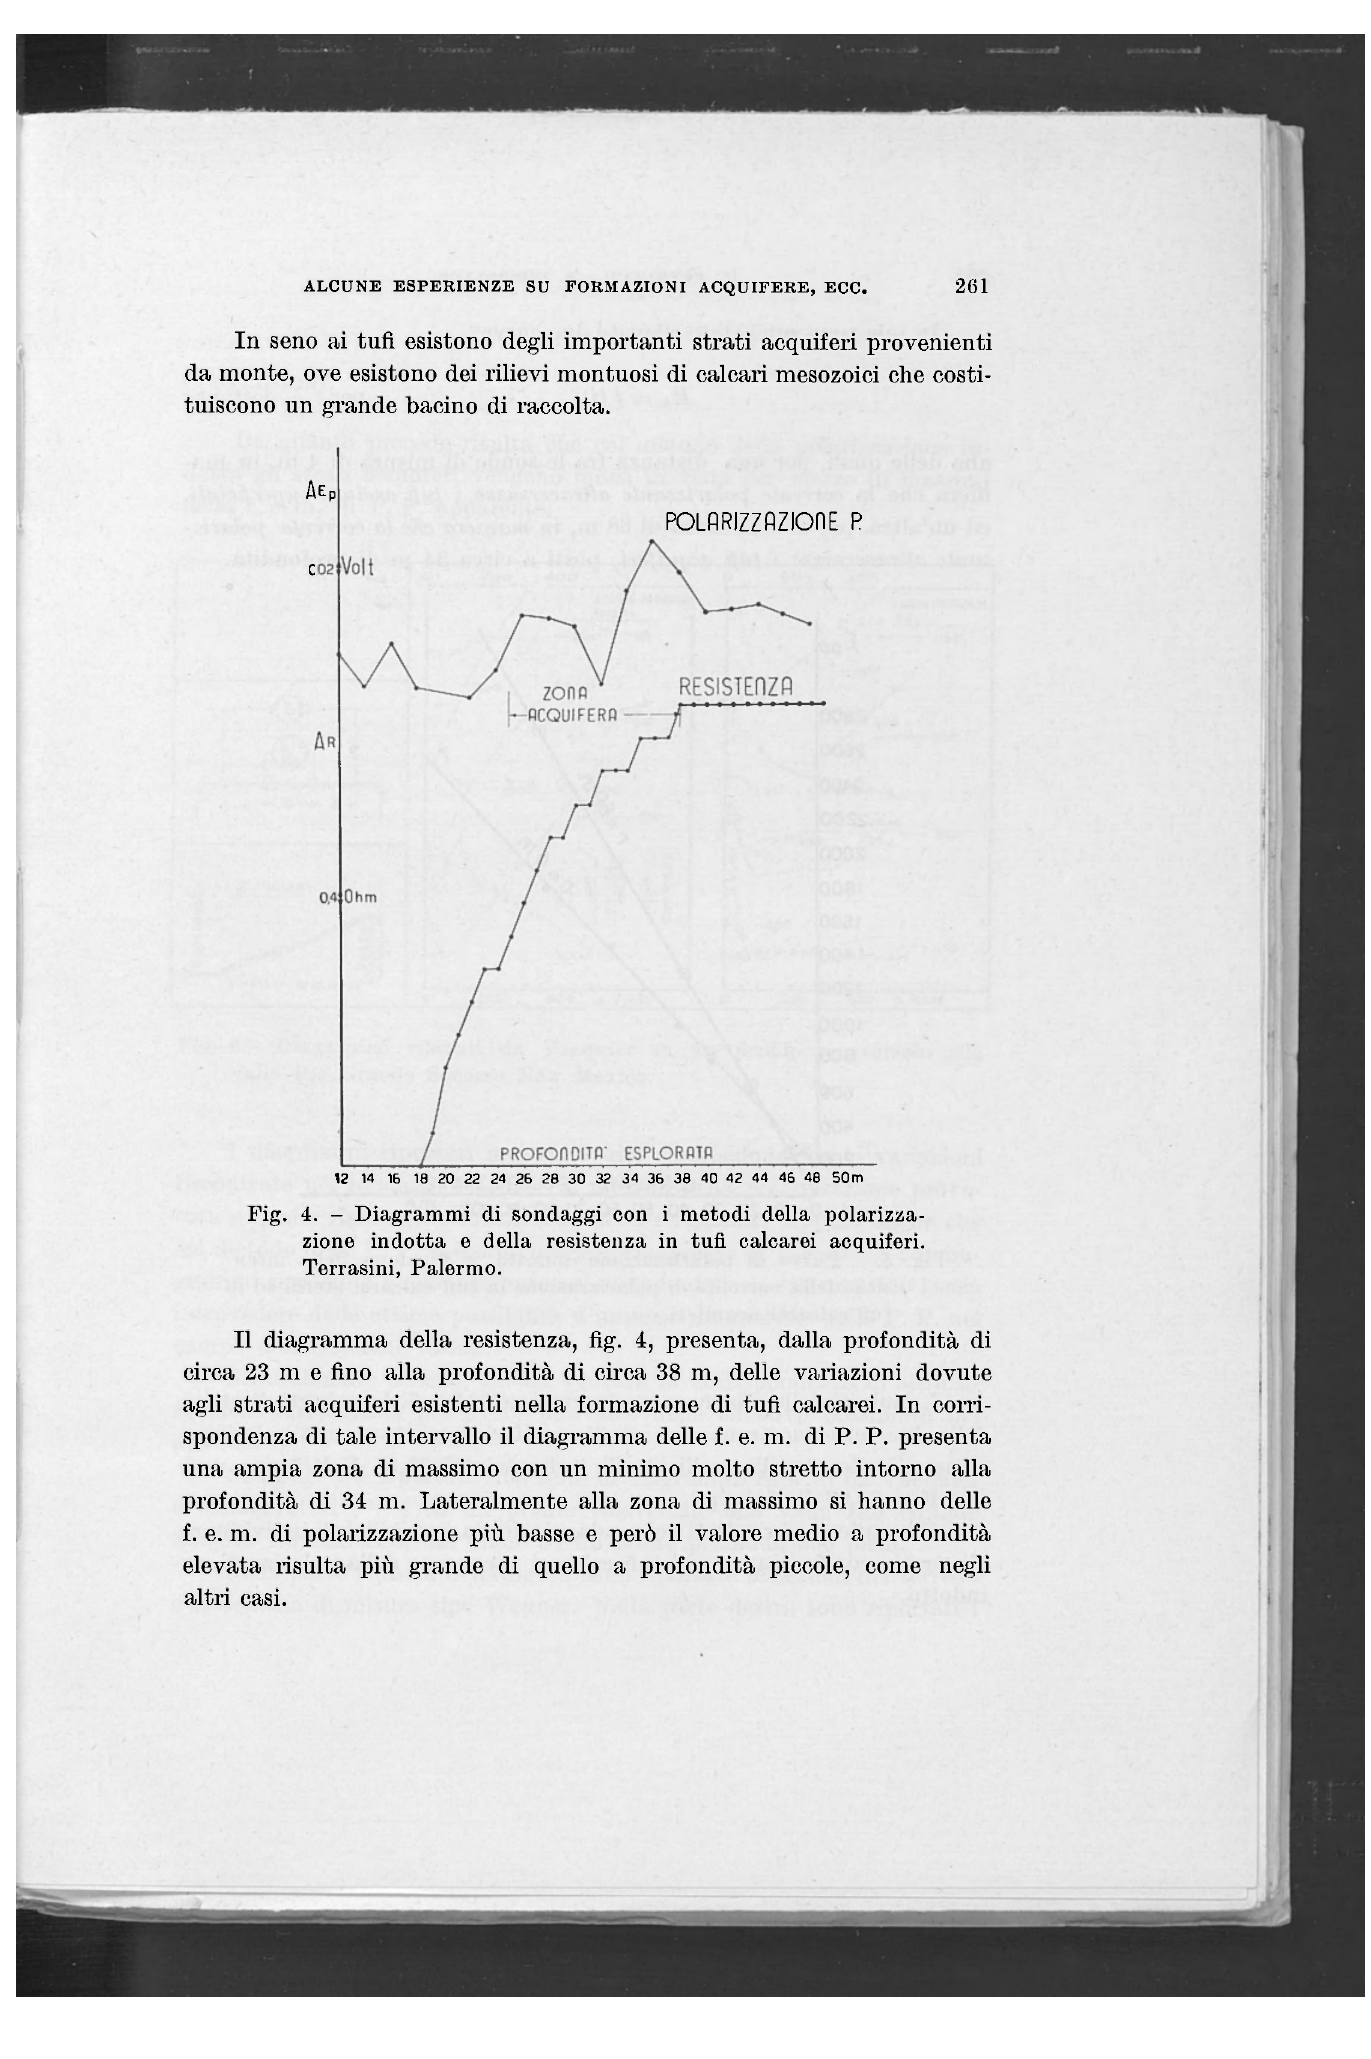
Fig. 4. - Diagrammi di sondaggi con i metodi della polarizza- zione indotta e della resistenza in tufi calcarei acquiferi. Terrasini,